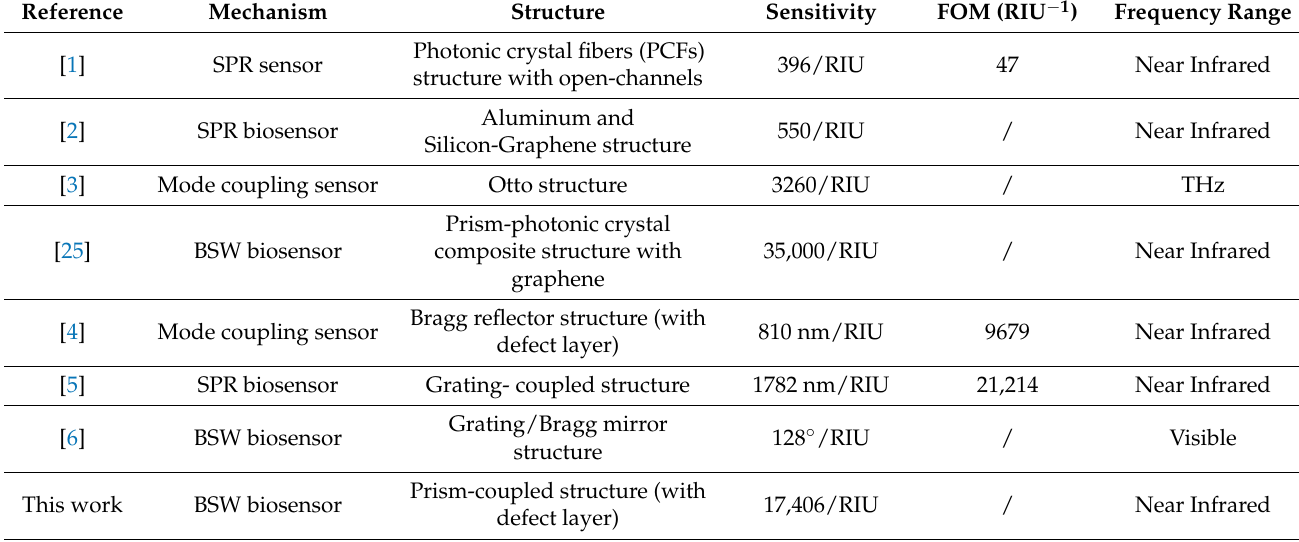
Table 2. Comparison between different refractive index sensing